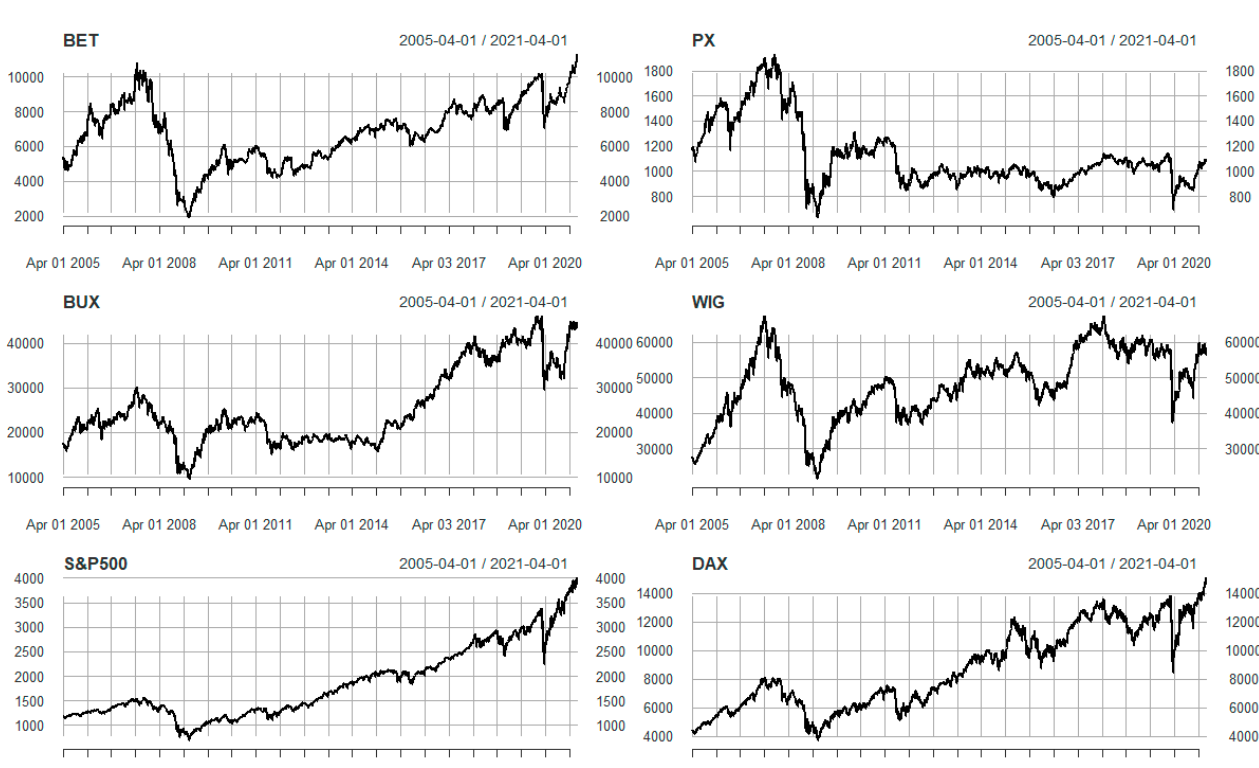
Figure A2. The Evolution of the Considered Stock Market Indices.